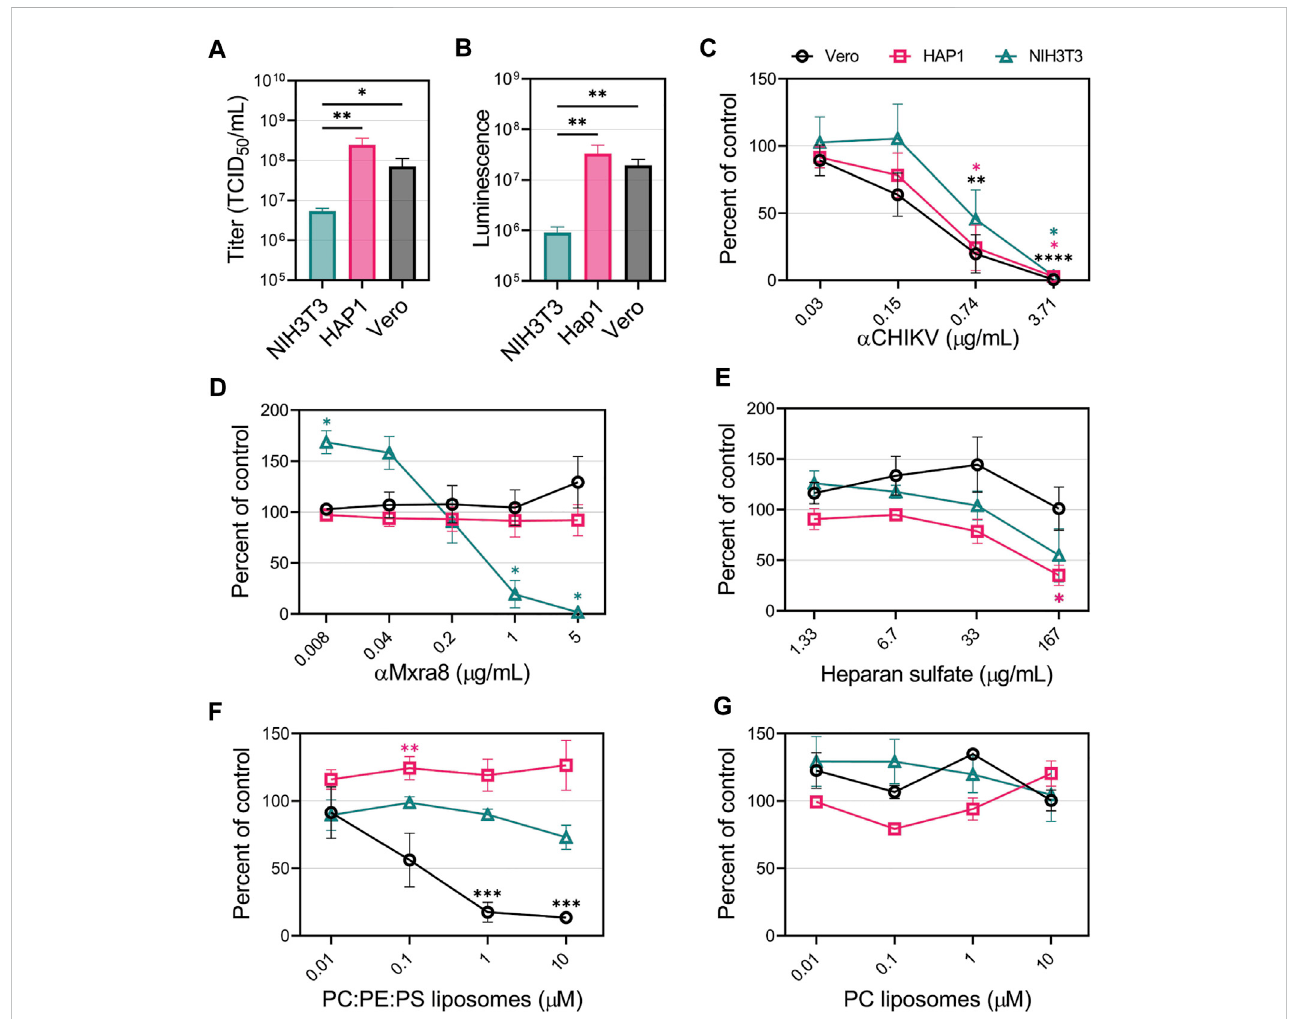
FIGURE 3 CHIKV viral apoptotic mimicry is cell-type dependent in mammalian cells. (A) CHIKV stock titers NIH3T3, HAP1, and Vero cells. (B) Luminescence levels produced by CHIKV-Nluc in NIH3T3, HAP1, and Vero cells after one round of replication. CHIKV-Nluc stocks were used to assess the ability of (C) CHIKV antibody, (D) Mxra8 antibody, (E) heparan sulfate, (F) PS-containing liposomes (75% PC: 20% PE: 5% PS), and (G) PC-only liposomes, to block infections into either NIH3T3 ( △ ), HAP1 ( □ ),or Vero ( ˆ x)mammalian cells attheindicated concentrations. Data arepresented as themean percent of control ± SEM from at least three independent experiments performed in duplicate or triplicate. For each treatment, the level of Nluc was measured and compared to the no inhibitoraddedcontroltodeterminepercentofcontrol. (A,B) UnpairedparametricStudent ’ st-testwasperformedtodeterminestatisticalsigni fi canceamong celllines (C – E) withunequalvariance(Welch ’ scorrection)comparedtoano-treatmentcontrol,or (F,G) comparingbetweenPC:PE:PSvs.PCliposomes.*, p < .05; **, p < .01; ***, p < .001; ****, p <